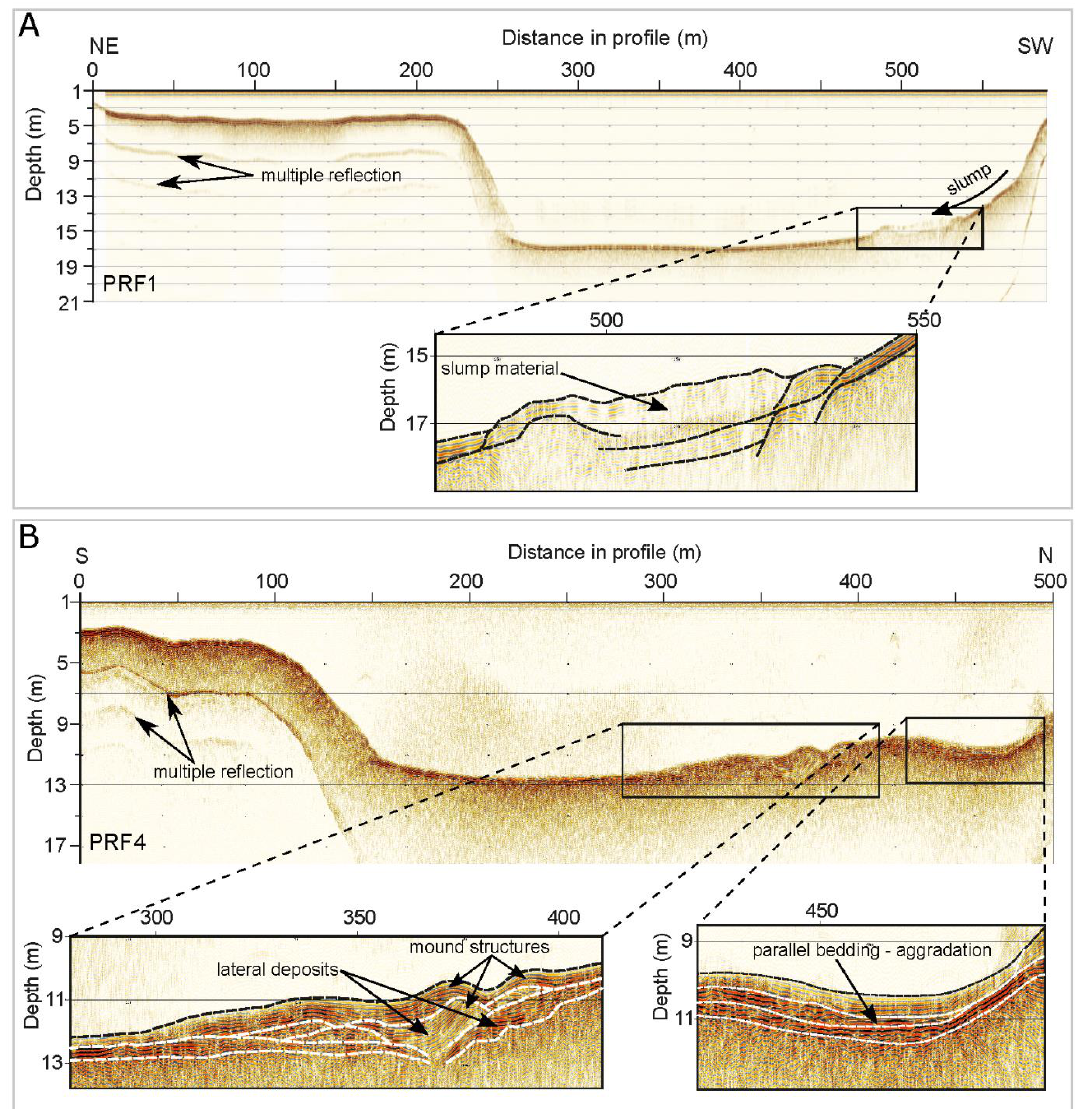
Figure 8. Profiler images in two selected profiles in the Nechranice inflow. ( A ) Profile PRF1, ( B ) profile PRF4.